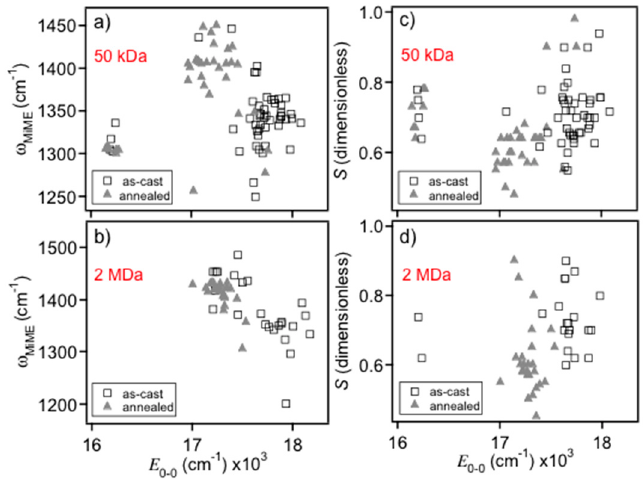
Figure 6. Histograms of the MIME progression interval and Huang–Rhys factor (S) for MEH-PPV chains dispersed in: 50 kDa ( a , c ); and 2 MDa ( b , d ) polystyrene before and after solvent vapor annealing.